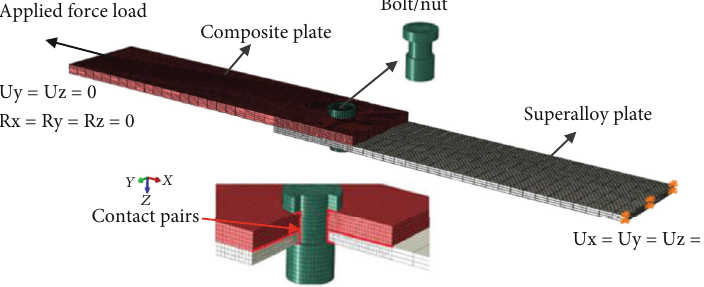
Figure 1: Finite element model and set contact pairs of a 2D C/SiC composite superalloy bolted joint